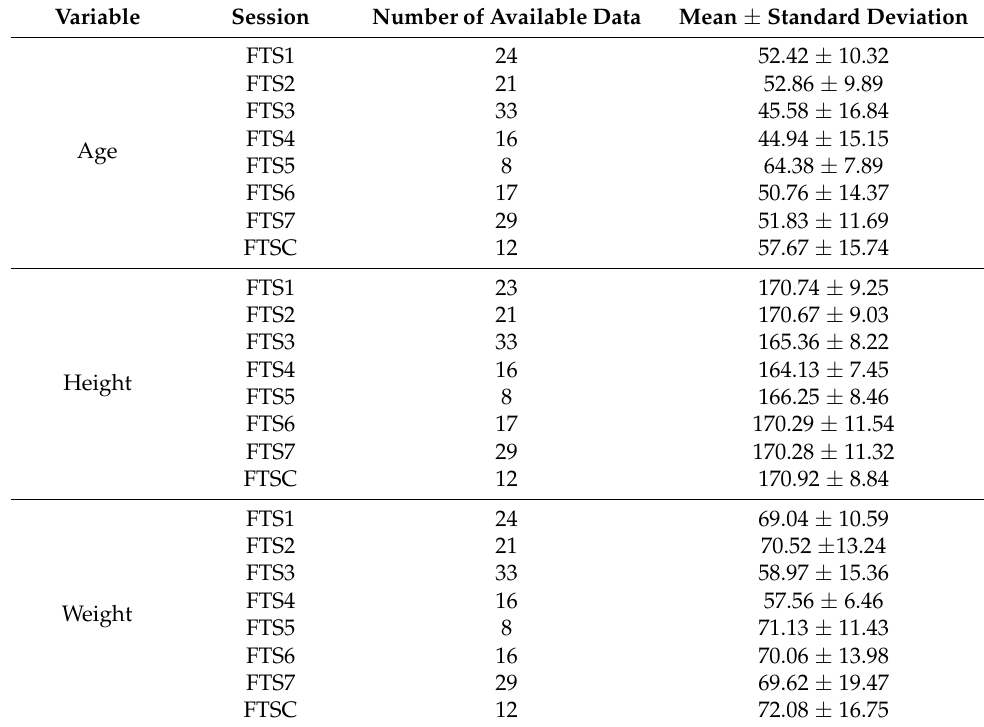
Table 2. Data about age, height and weight of participants to each forest therapy session. Variable